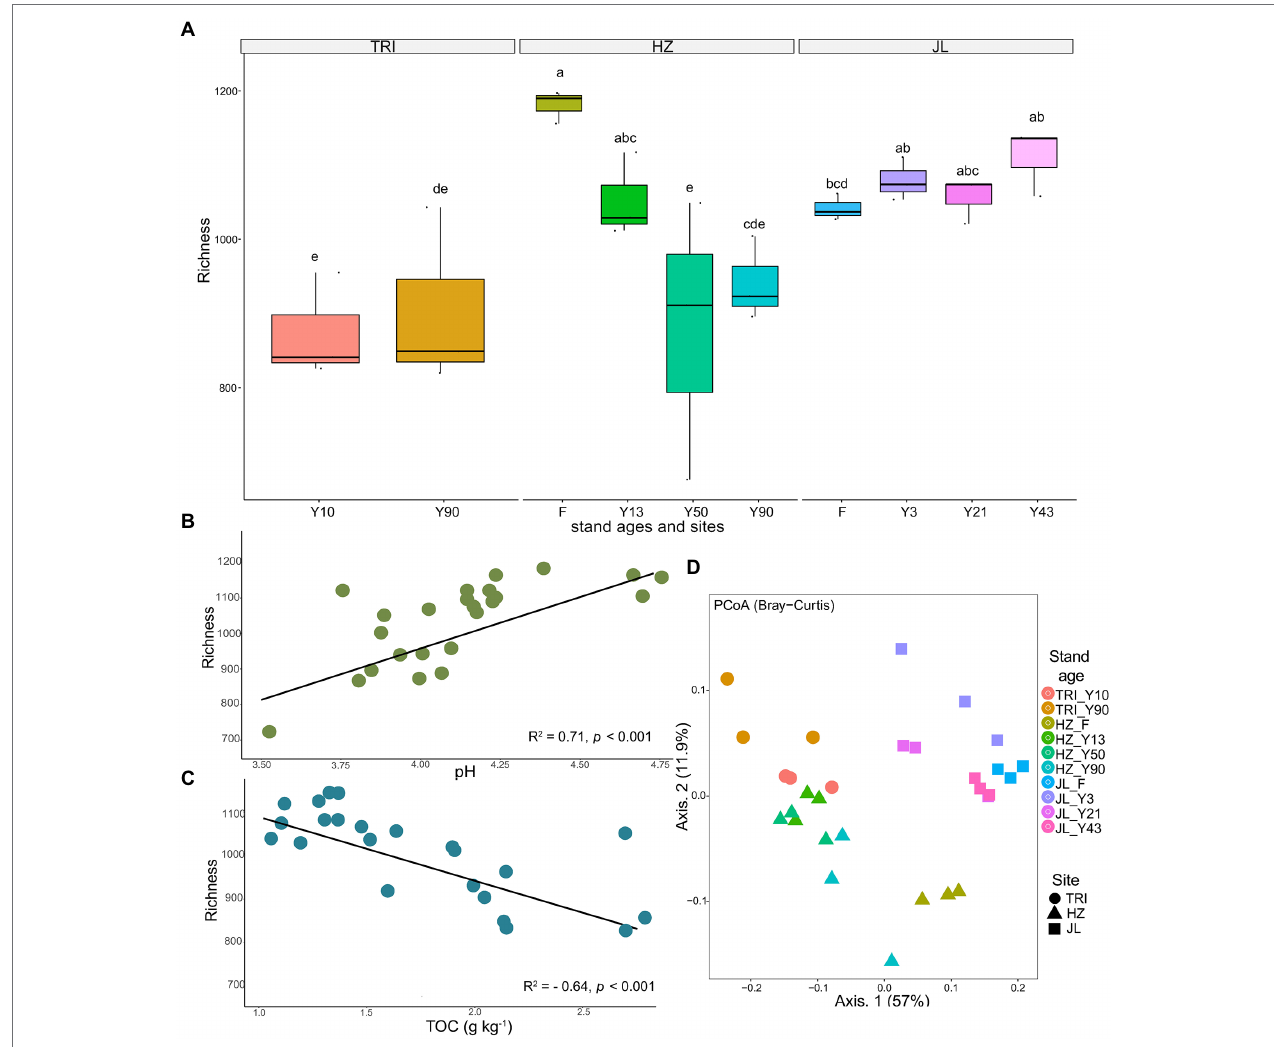
FIGURE 3 | (A) The richness of the tea plantation soil bacterial communities at varying stand ages and different sampling sites. (B,C) show significant linear regression ( p < 0.001) relationships between total carbon (TOC) and soil pH in the soil, respectively, and the richness of soil bacterial communities across all tea stands. (D) Principal coordinate analysis (based on Bray–Curtis distances) of soil bacterial community composition across varying stand ages and different sampling sites. The samples are separated by sites (TRI, HZ, and JL; represented by different shapes) and stand ages [F (adjacent forest); represented by different